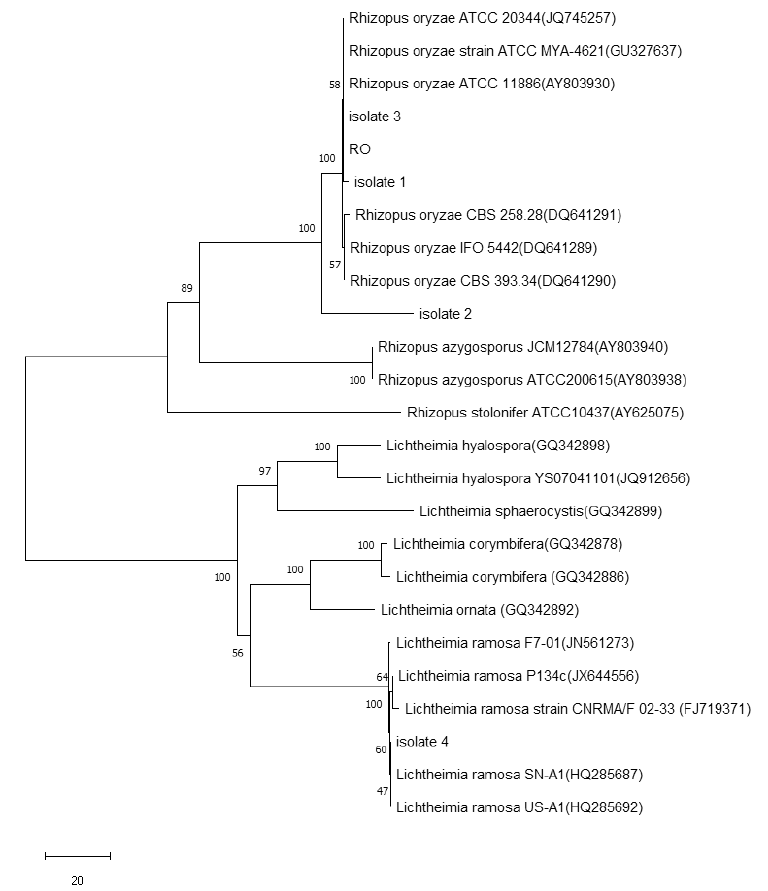
Figure 2. Phylogenetic tree obtained using the neighbor-joining method for 18S rDNA sequences of strains 1, 2, 3 and 4, and members of related fungi. The numbers at the branch points are bootstrap values for parsimony-based analysis.